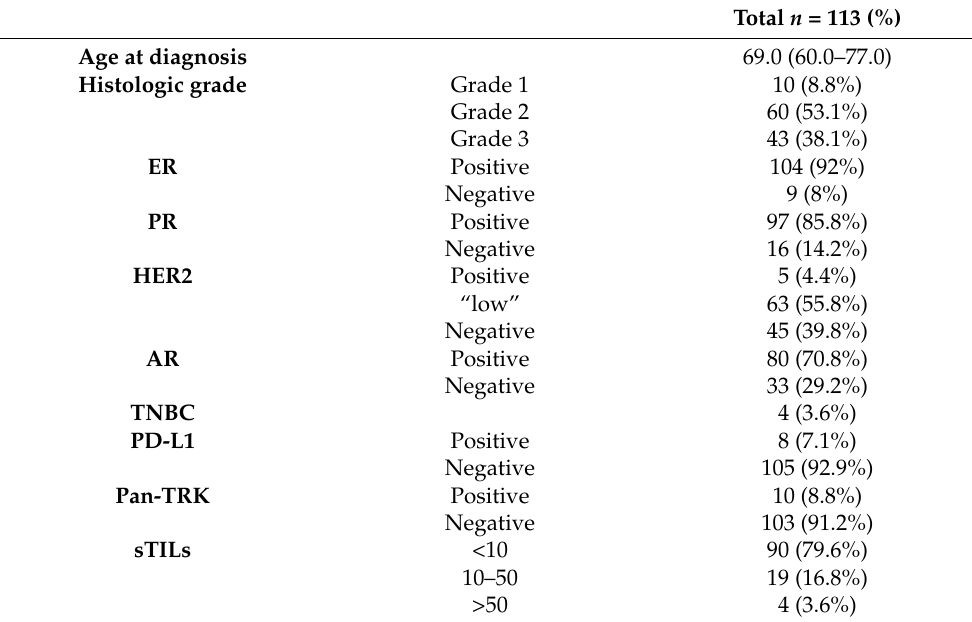
Table 1. Baseline patient and tumor characteristics including sTILs, PD-L1 IC score and pan- TRK‘expression.